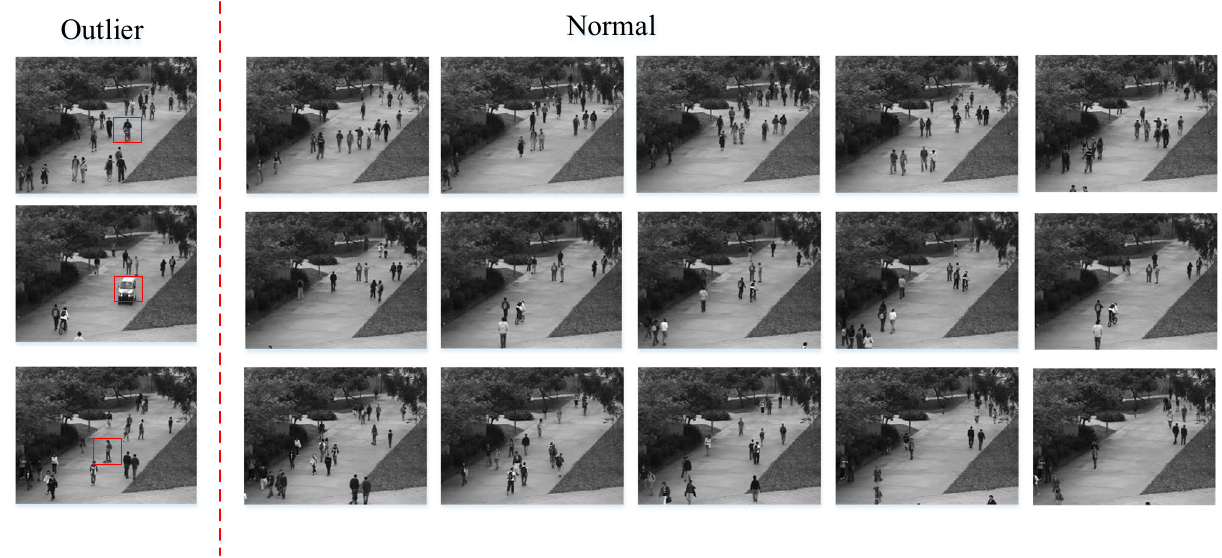
Figure 8. Video outlier detection dataset. The outliers on the leftmost are anomalous events on the sidewalk with bikers, small carts and skaters, and we have highlighted the cause of the anomaly with a red rectangle.